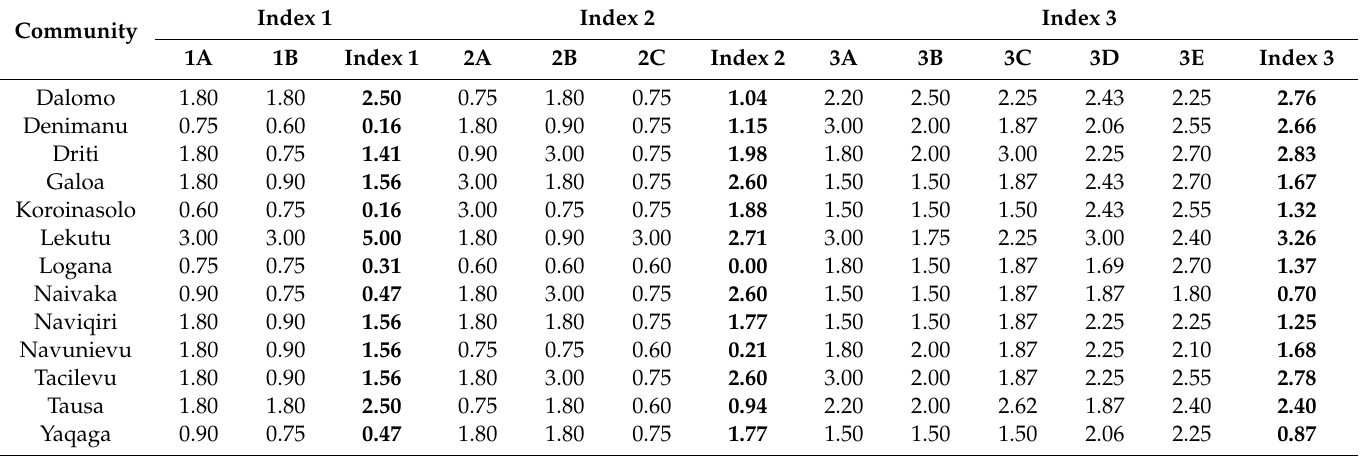
Table 2. Calculation of peripherality